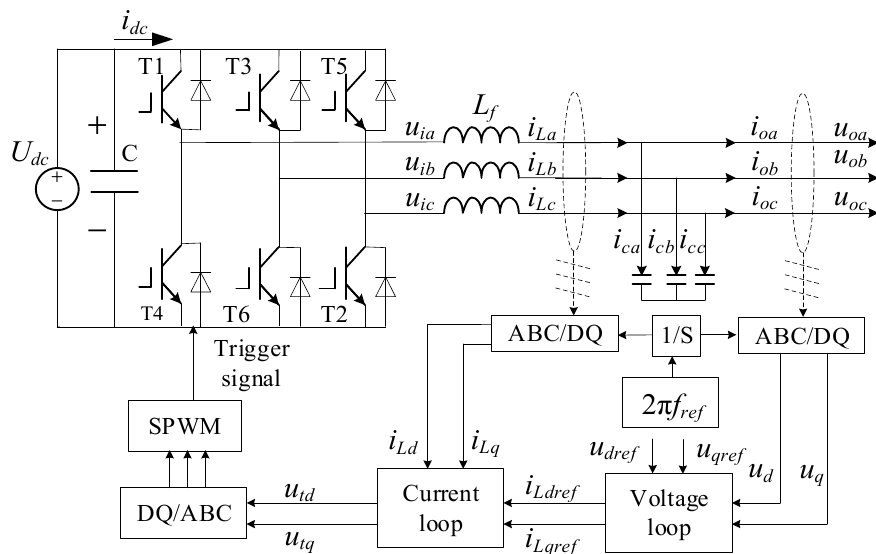
Figure 1. Single converter